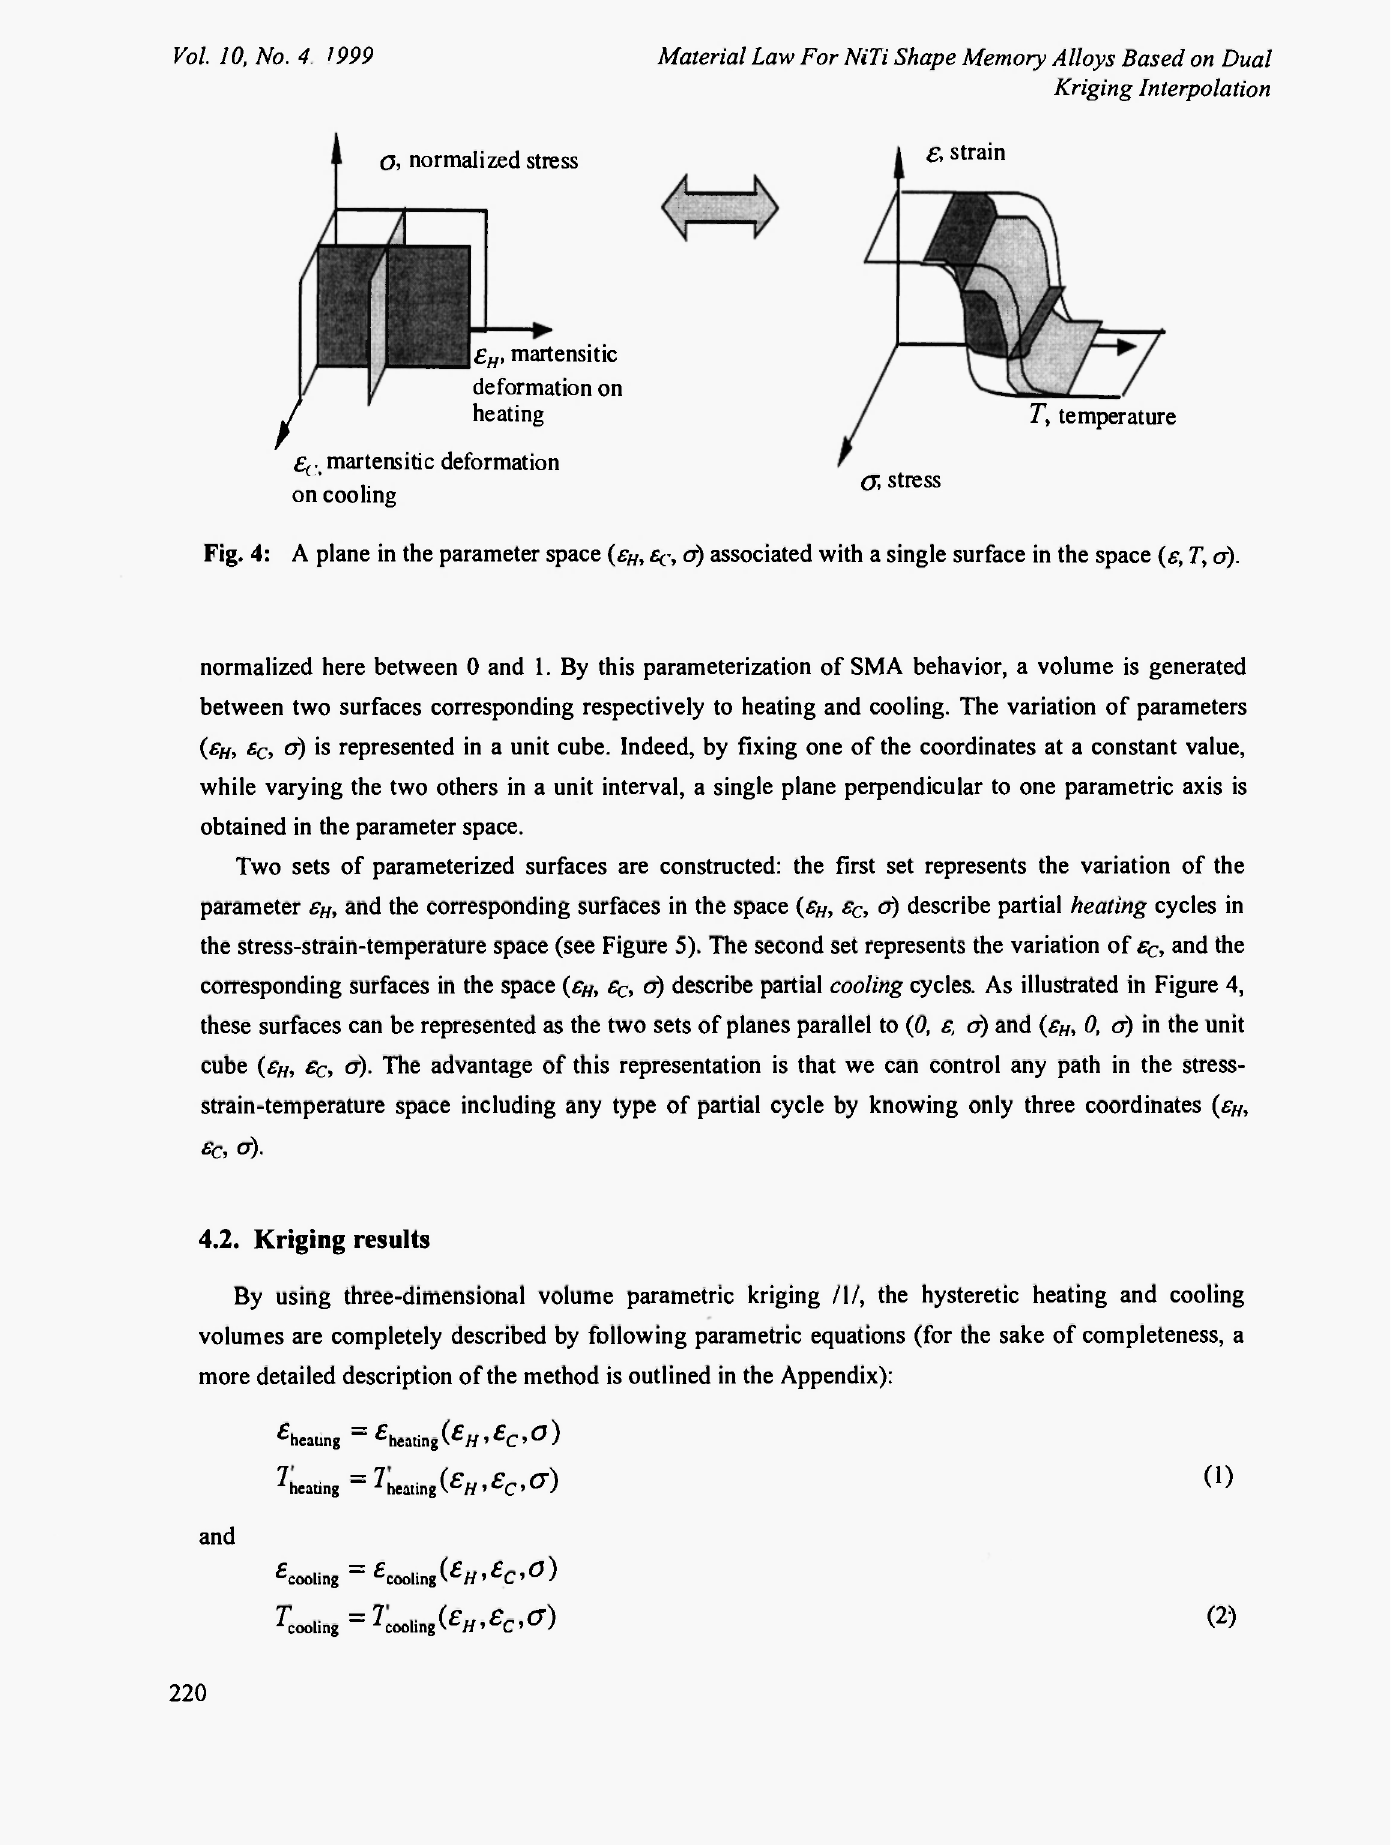
Τ, temperature (j, stress , £<-, σ) associated with a single surface in the space (ε, Τ, Η